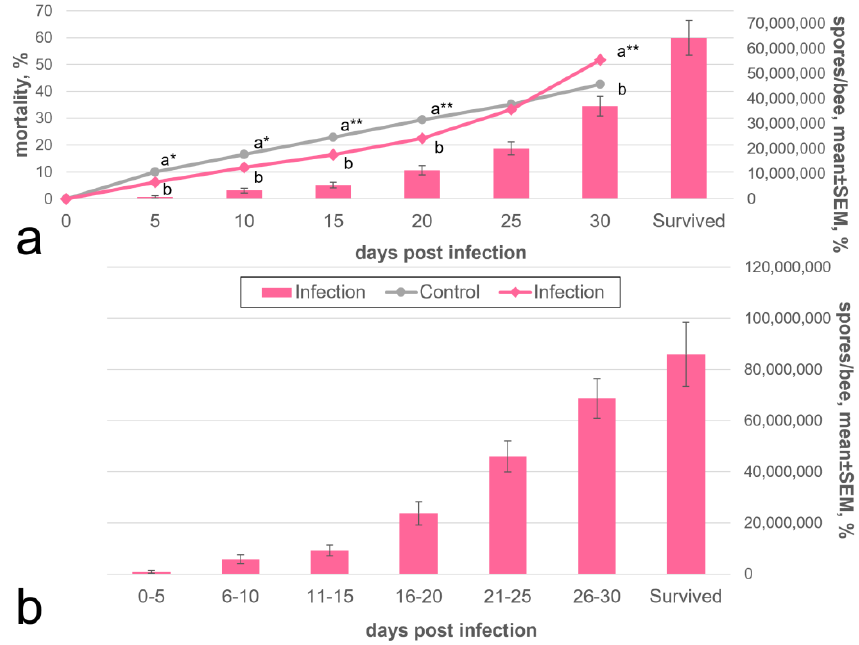
Figure 6. Dynamics of Vairimorpha ceranae development in adult honey bees, maintained at 33 ◦ C and experimentally infected with 1 million spores/bee. Spores were isolated from dried honey bee cadavers stored at room temperature. The mean number of spores per bee was calculated using estimates of the total amount of bees from the beginning of the experiment ( a ) or within a given time interval ( b ). The indications are as in Figure 2. The data which this scheme was created from are found in Table S5.